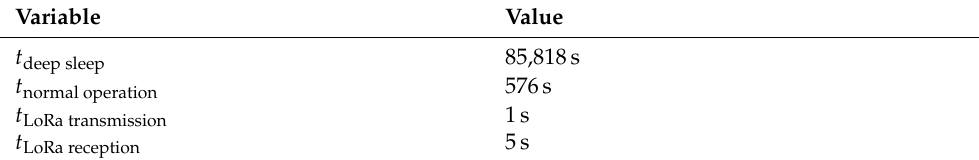
Table A1. Time duration in each phase on a daily basis for the MIRRA sensor node.